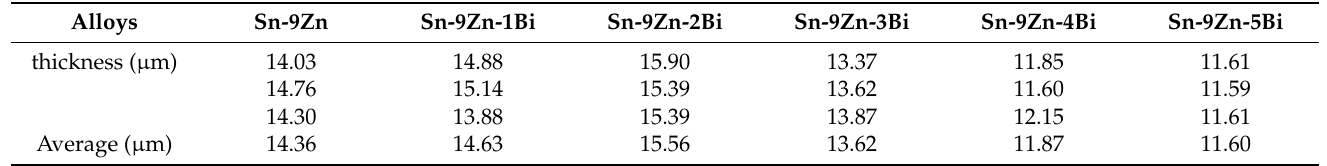
Table 5. Average thickness of the IMC layer after soldering.